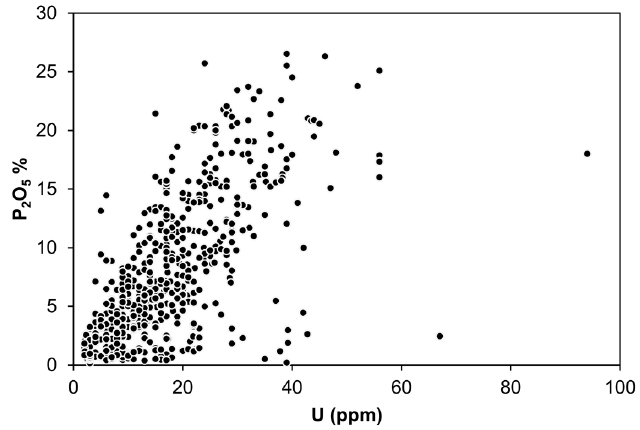
Figure 7. Biplot of P 2 O 5 versus U in Estonian phosphorites based on the digitized historical dataset.